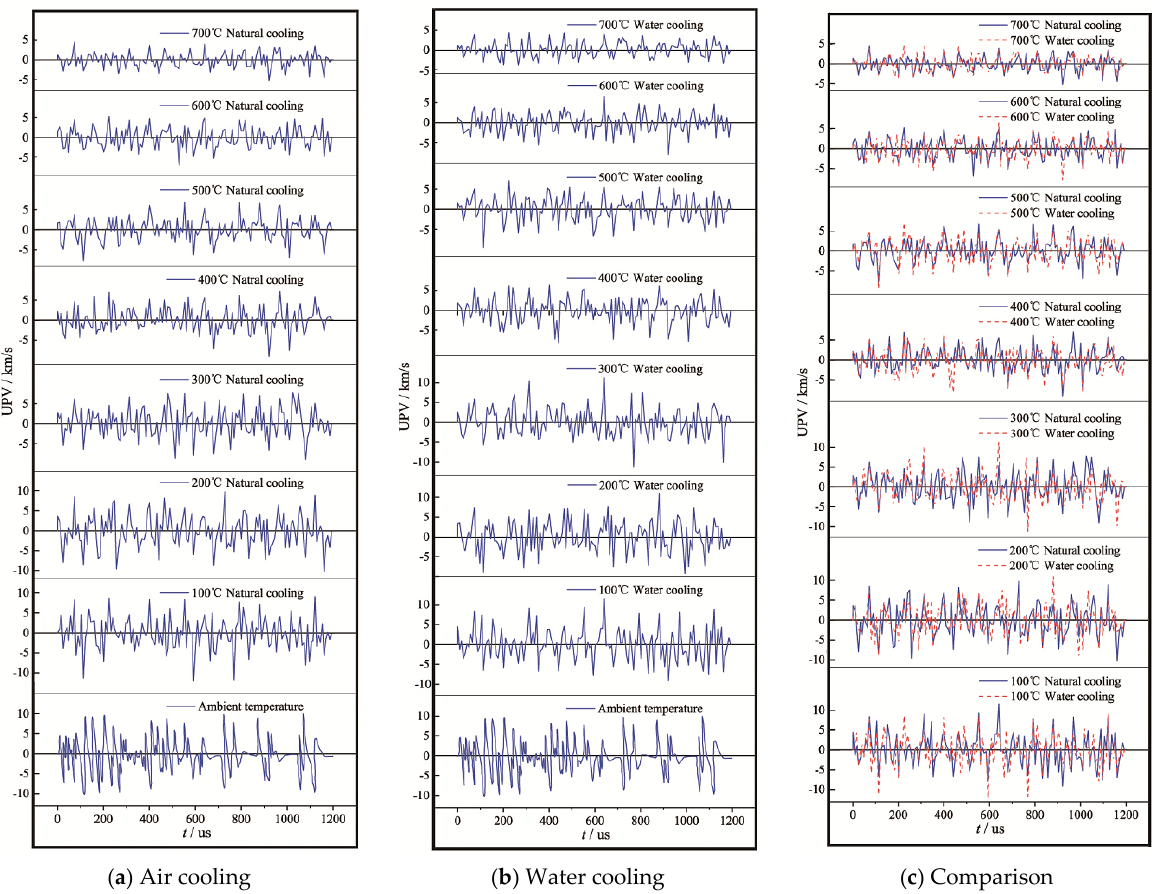
Figure 6. The velocity − time graphs of the SCC specimens after being heated and cooled.